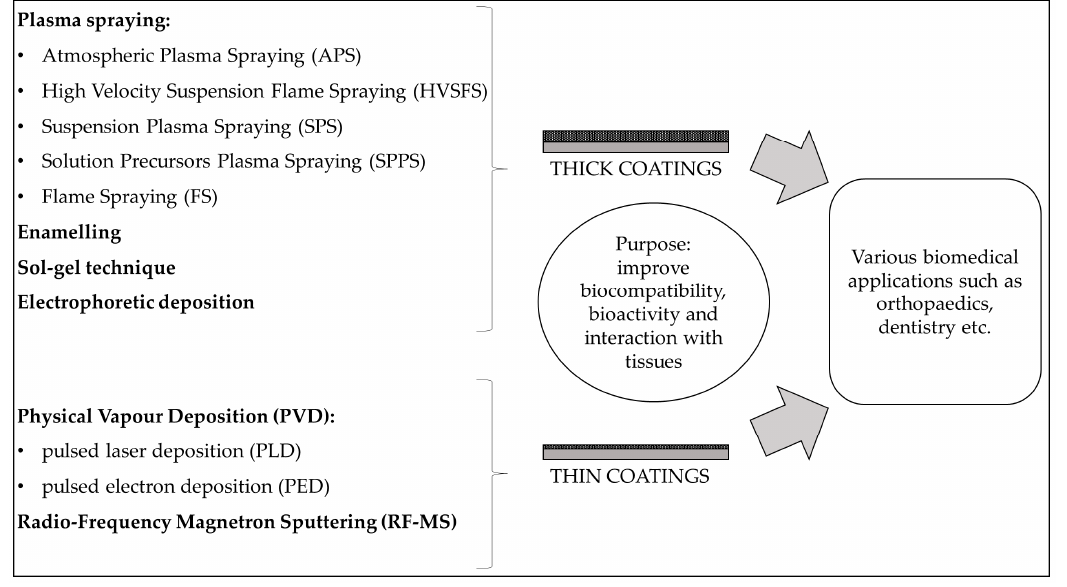
Figure 1. Principal techniques for bioactive glass coatings.